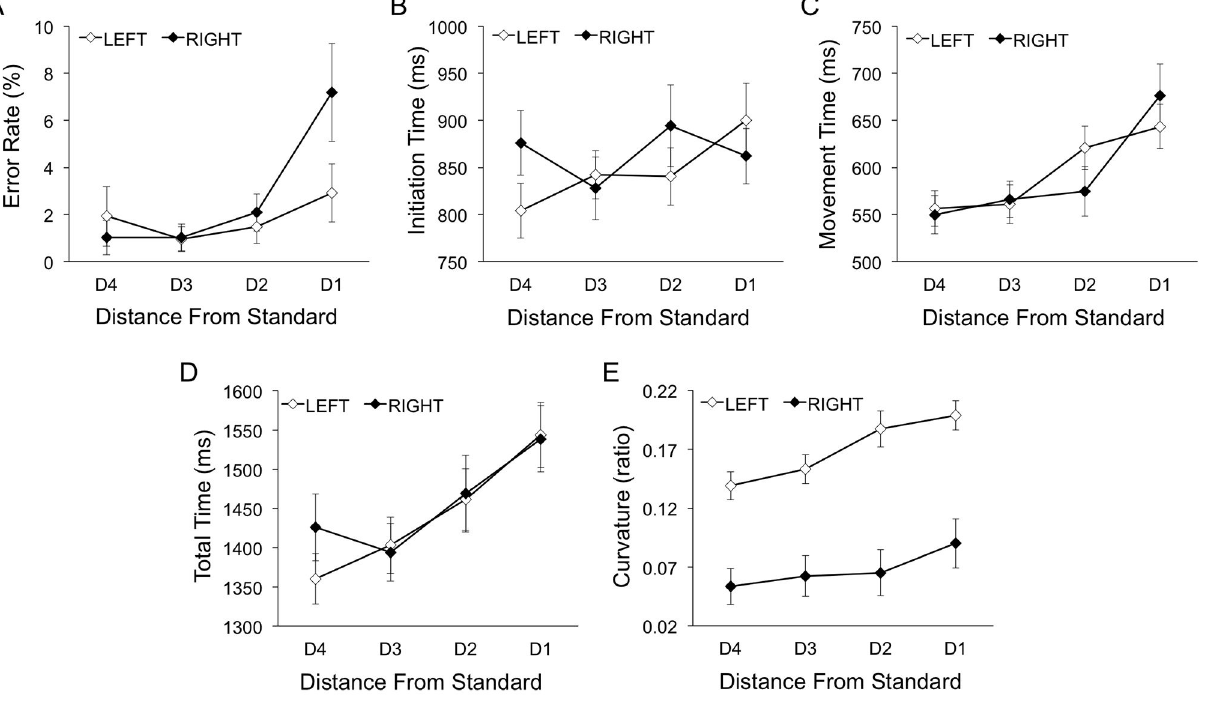
Figure 2. Average error rate (A), initiation time (B), movement time (C), total time (D), and curvature (E) for each distance score as a function of response location (left, right). Error bars indicate standard